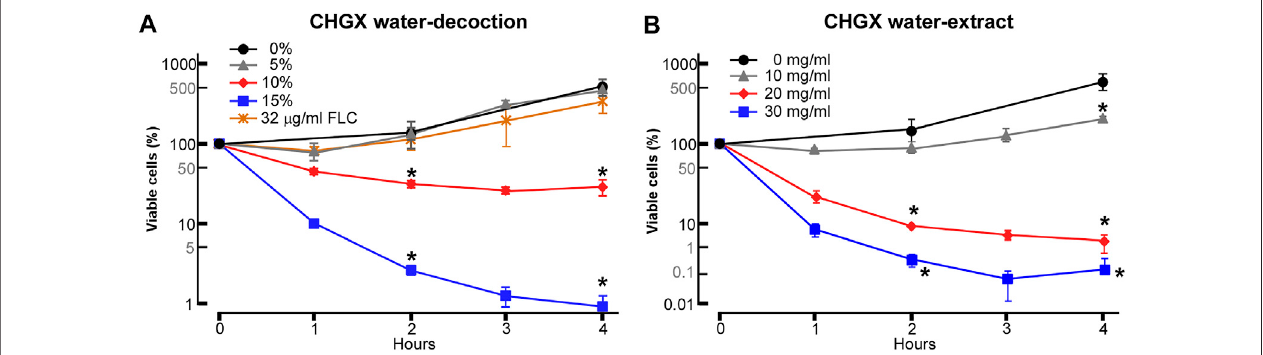
FIGURE2| KillingactivityofCHGXagainst C.albicans .SC5314cellswereusedforrepresentativestrainof C.albicans .SC5314 cellswereinitiallycultured inliquid YPD medium at logarithmic phase, and were then harvested, washed, and re-suspended in liquid Lee ’ s glucose medium for time-kill kinetics assay. SC5314 cells (2 × 10 5 cells/ml) were treated withvarious concentrationsofCHGX water-decoction (A) or CHGX water-extract (B) for0 – 4 h at 30 ° C inLee ’ sglucose medium, and the percentagesofviable cellswere determined usingplatingassays. Fluconazole (FLC) wasused ascontrol. Three biologicalrepeats were performed, and thevalues are presented as mean ± SD. One-way analysis of variance (ANOVA) was used to compare differences between CHGX water-decoction or CHGX water-extract untreated samples and CHGX water-decoction or CHGX water-extract treated samples; *, p < 0.05.